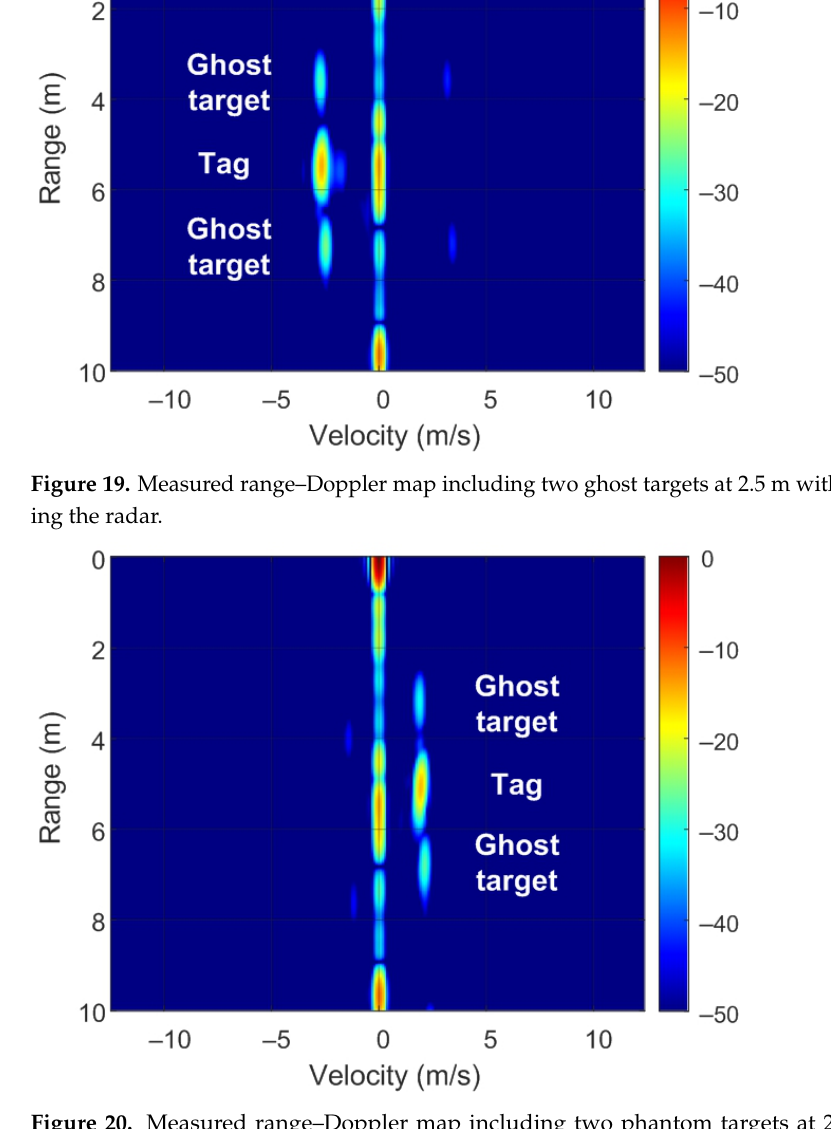
Figure 20. Measured range–Doppler map including two phantom targets at 2.5 m with the tag moving away from the